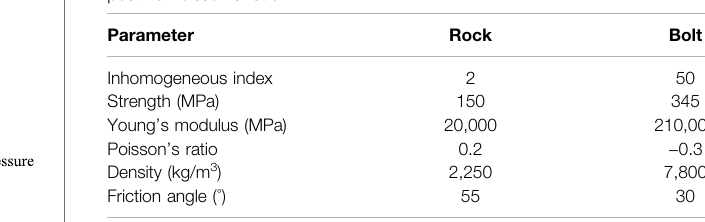
TABLE 1 | Physical and mechanical parameters of the rock and the bolt with a positive Poisson ’ s